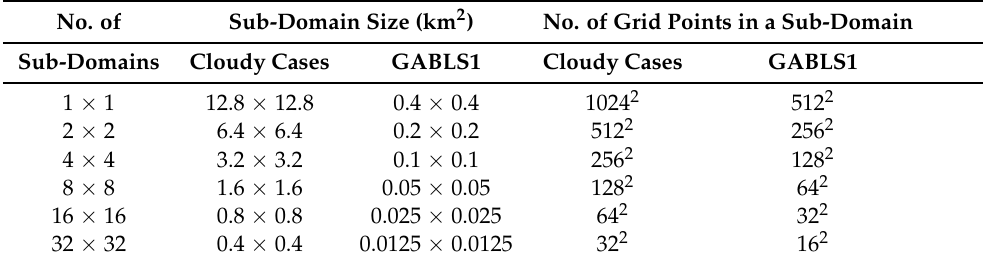
Table 2. A summary of the sub-domain sizes and number of grid points in a sub-domain for the cloudy cases (ARM, BOMEX, DYCOMS-II, and RICO) and the GABLS1 case. No. of Sub-Domain Size (km 2 ) No. of Grid Points in a